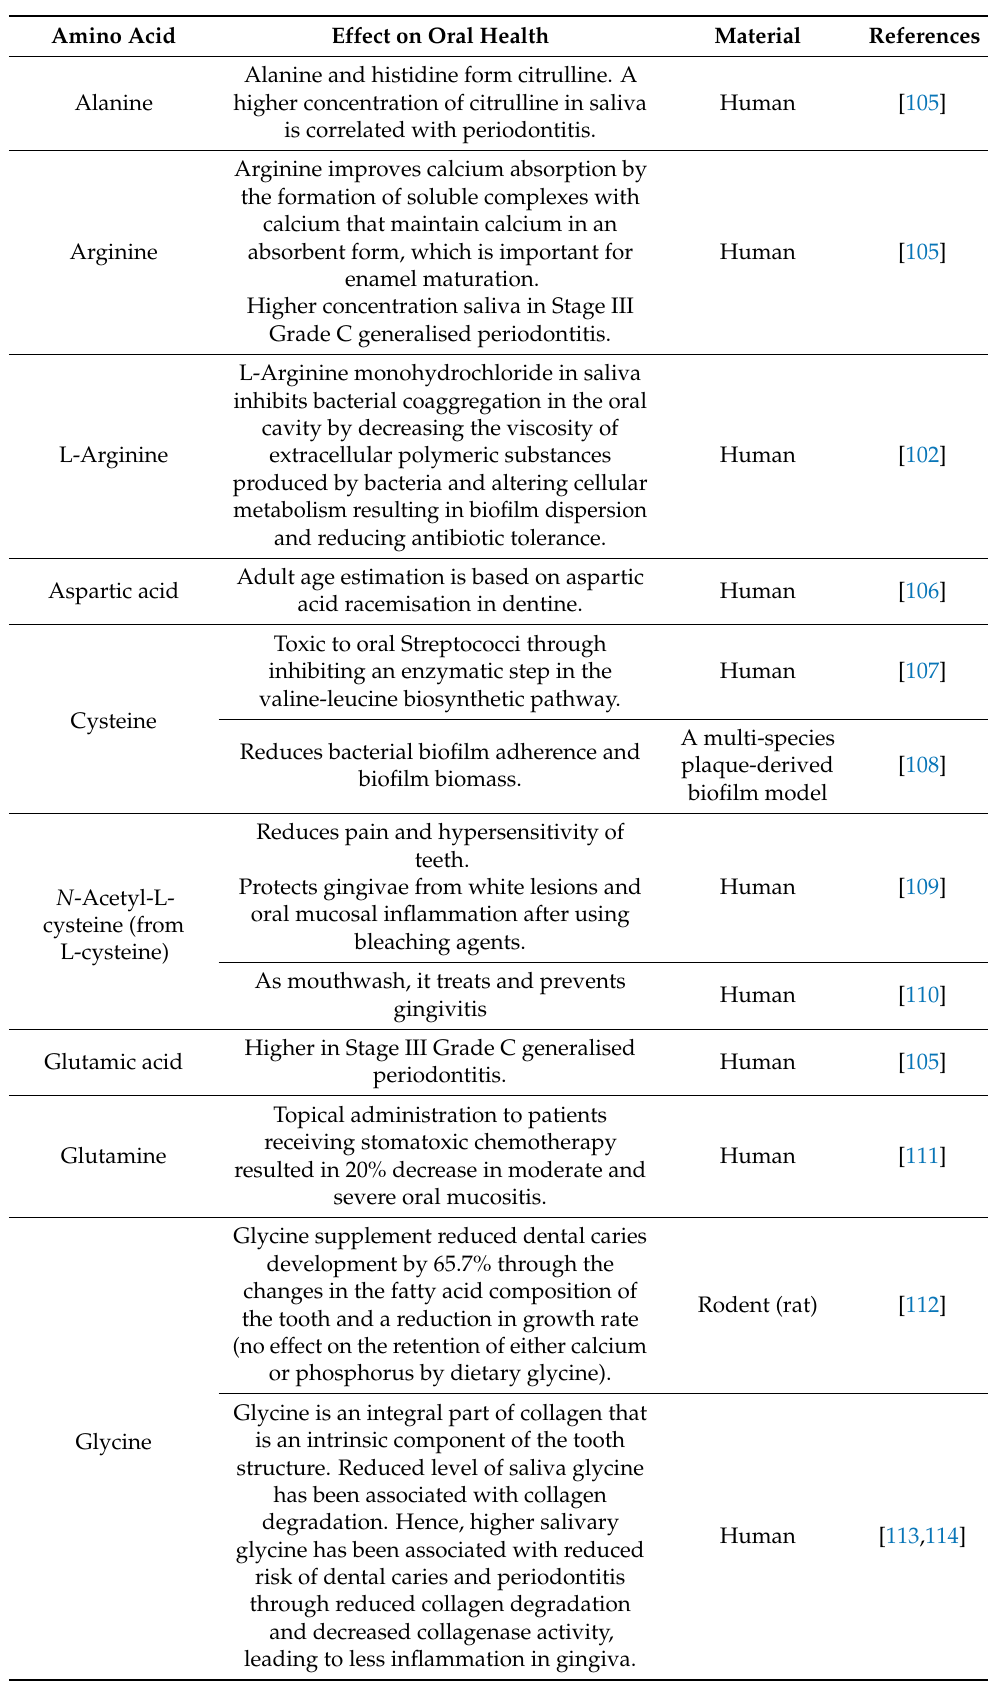
Table 1. Effect of amino acids on oral